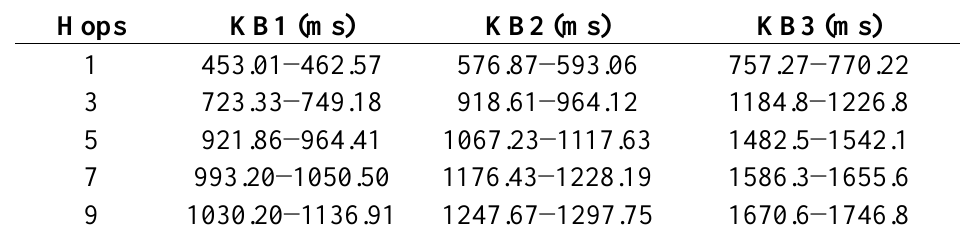
Table 3. RTT distribution of KBs interval in which the probability of meeting the parameter ―expected value‖ is 0.95.